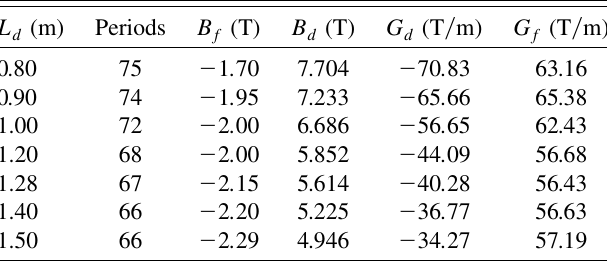
TABLE II. Major magnet length, number of periods, magnetic fields, and gradients in the QF and QD magnets.